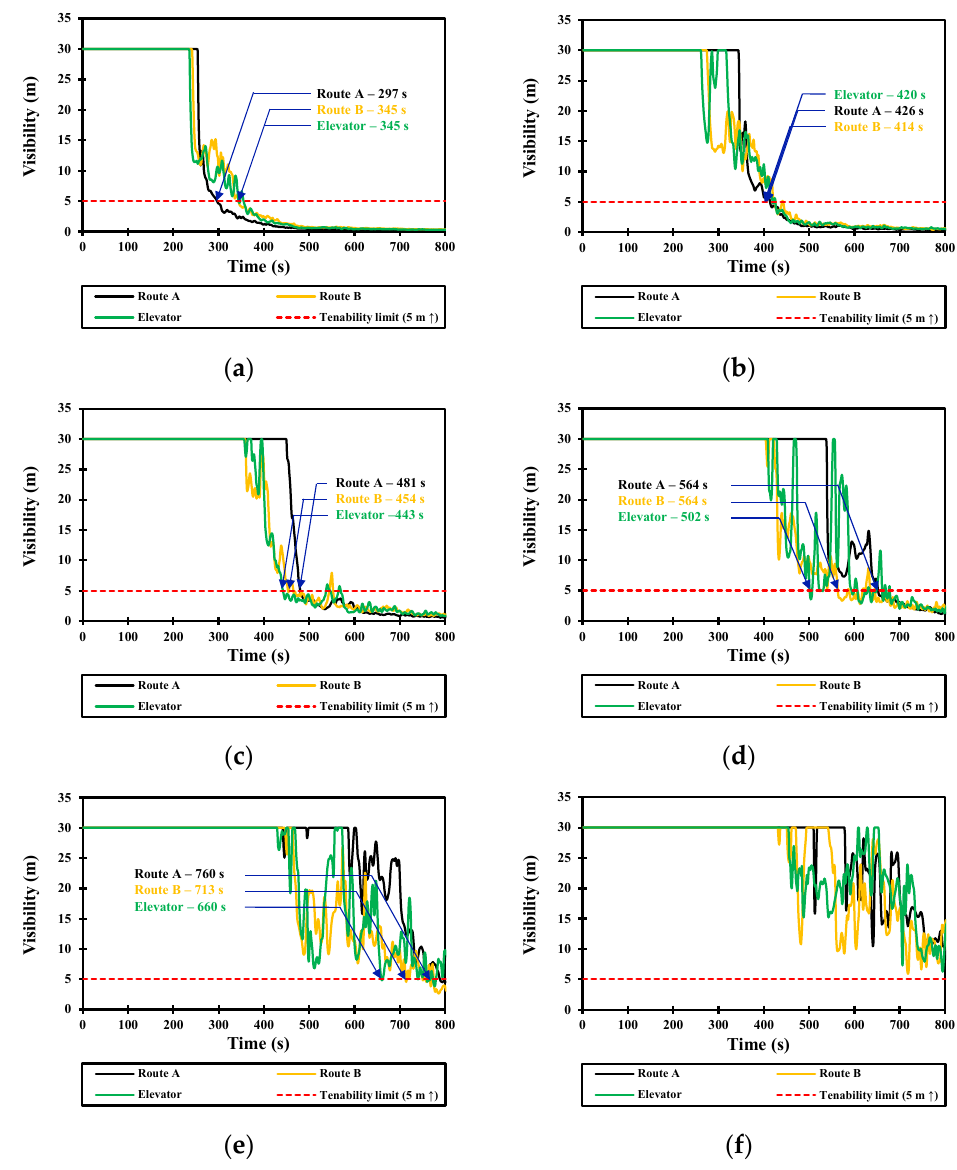
Figure 6. ( a ) Capacity of smoke exhaust system 3.125 m 3 /s; ( b ) capacity of smoke exhaust system 6.25 m 3 /s; ( c ) capacity of smoke exhaust system 9.375 m 3 /s; ( d ) capacity of smoke exhaust system